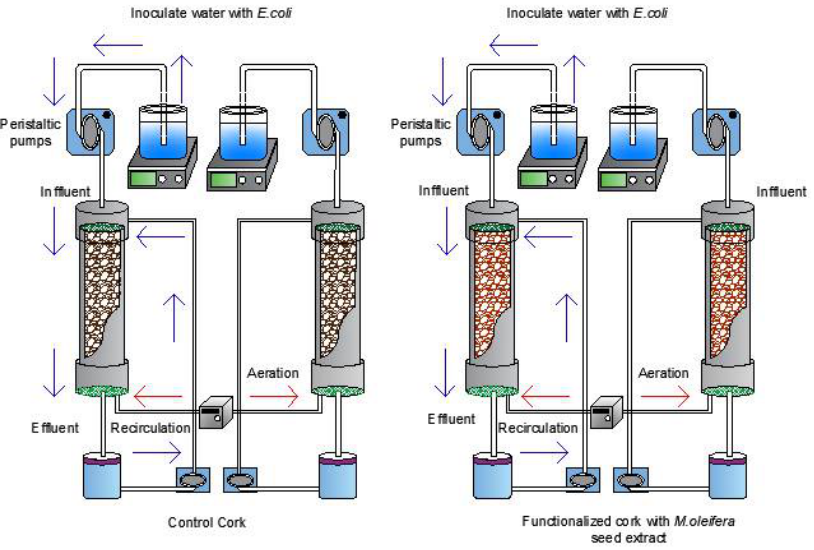
Figure 1. Biofilter system functionalizated with Mo Se .